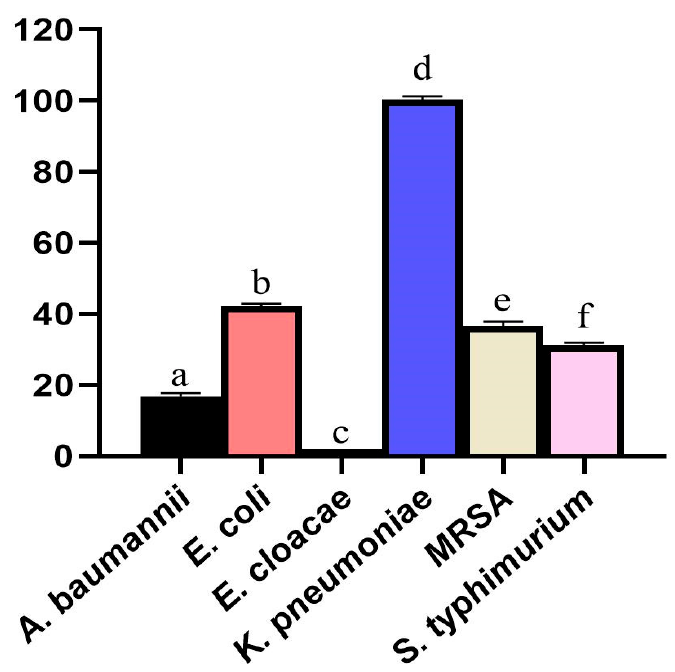
Figure 14. Synergistic proportions of the greenly prepared ZnO-NPs with fosfomycin against bacterial pathogens (Different letters revealed that the values were significantly different ( p ≤ 0.05)).